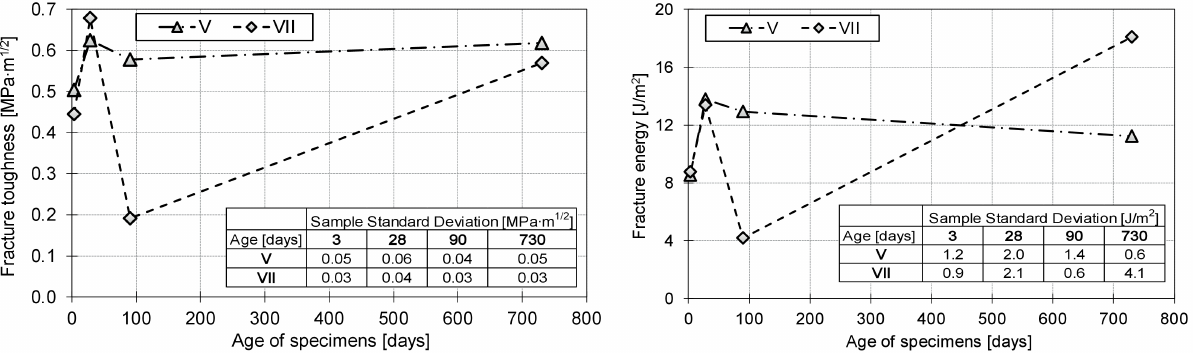
Figure 5. Development of the effective fracture toughness(left) and the specific fracture